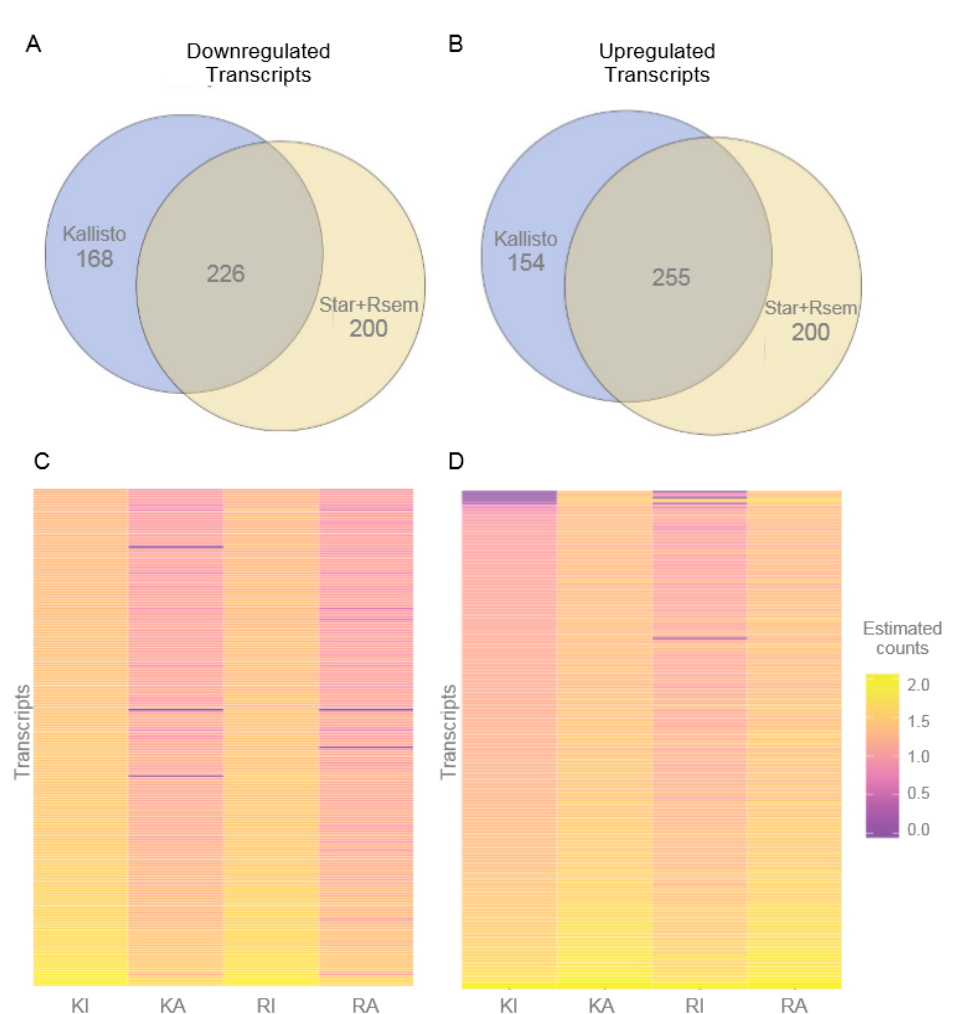
Figure 2. Differentially expressed genes between potassium chloride (KCl)-activated and control iPSC-derived neurons. Differentially expressed genes were identified using the alignment-free method implemented in Kallisto, and the alignment-based combined approach of STAR+RSEM. ( A ) Venn diagram showing genes with decreased expression in KCl-activated neurons were identified by each strategy and compared, revealing an intersection of 226 transcripts that were characterized as the valid set of downregulated transcripts. ( B ) Genes with increased expression in KCl-activated neurons were identified by each strategy and compared, revealing an intersection of 255 transcripts that were characterized as the valid set of upregulated transcripts. ( C ) Expression of downregulated genes (226 genes) and ( D ) expression of upregulated genes (255 genes) visualized as a heatmap where the color of each cell represents estimated and normalized read counts from purple to orange (i.e., low to high expression, in a logarithmic scale). KI: control sample assessed by Kallisto; KA: activated neurons sample assessed by Kallisto; RI: control sample with read counts from RSEM; RA: activated neurons sample with read counts from RSEM.